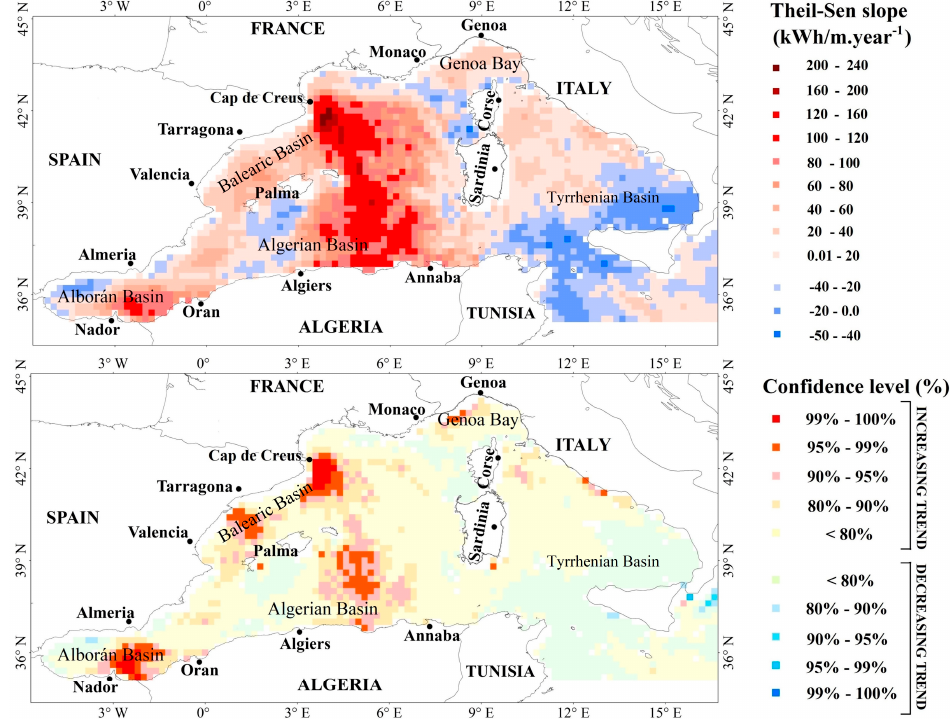
Figure 5. Spatial distribution of long-term trends (Theil–Sen slope in kWh·m − 1 ·year − 1 ) of the annual maxima of the total storm wave energy (TSWE) ( upper panel ) and their significant trends according to the Mann–Kendall test at different confidence levels ( lower panel ).